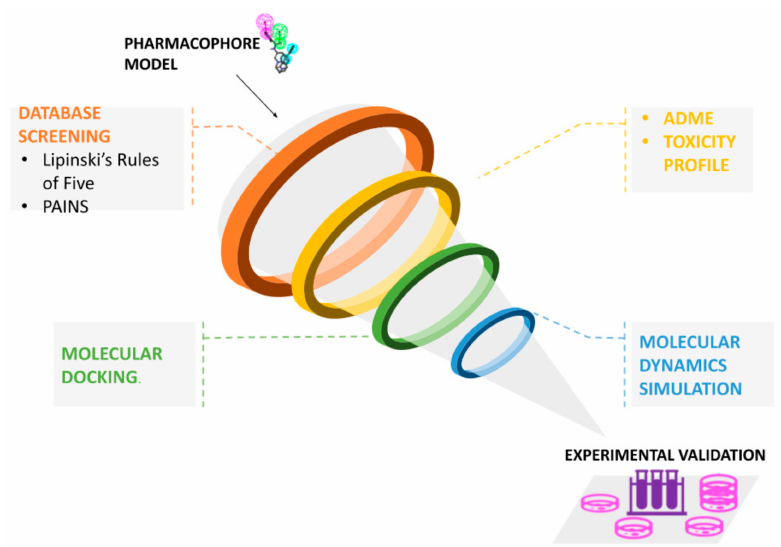
Figure 4. Virtual screening workflow. Basic filters and methods applicable for a virtual screening process. Scheme of the multistage vs. approach. The application of vs. follows a typical sequence of processes with a cascade of filters able to narrow down and choose a set of hits with potential biological